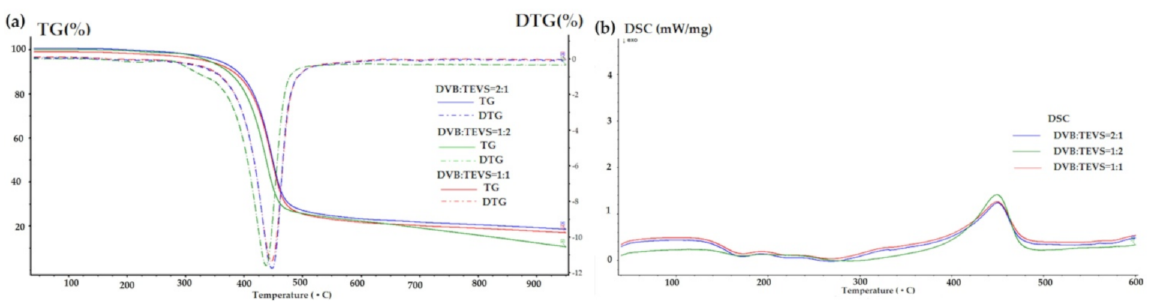
Figure 12. TG, DTG ( a ) and DSC ( b ) curves for DVB-TEVS materials measured in helium conditions after adsorption of P.